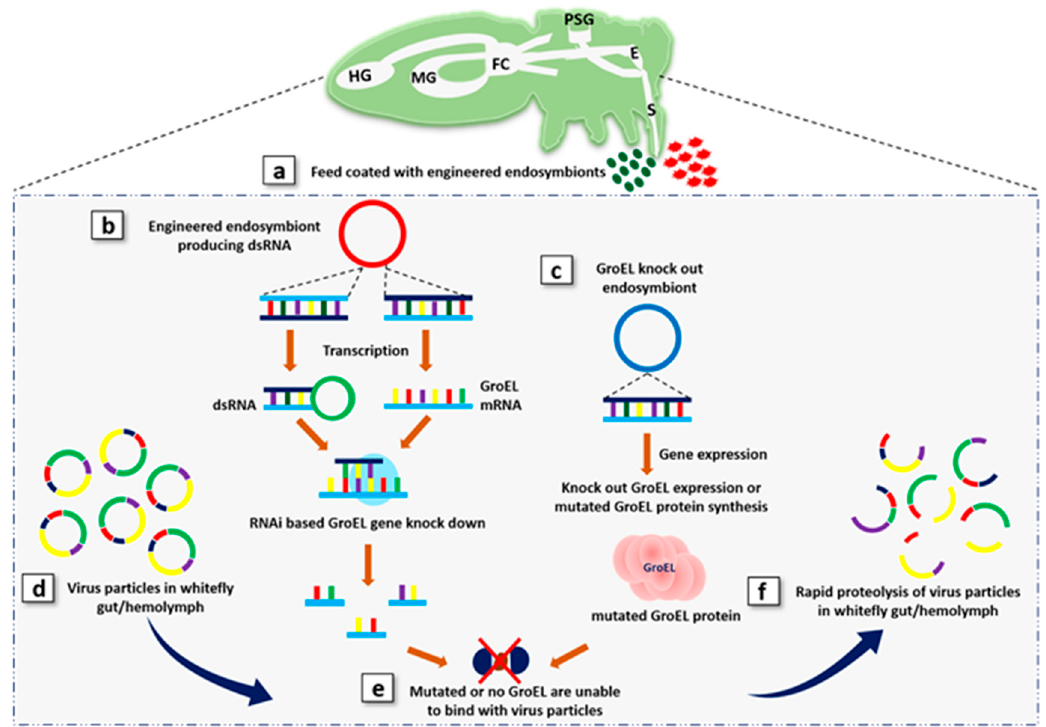
Figure 3. A proposed strategy to knockdown virus transmission by whitefly with the CRISPRCas9 system and RNA interference (RNAi) approach. ( a ) Feed coated with dsRNA, producing engineered bacterial endosymbionts (green particles) and the knockout/mutated GroEL gene, containing engineered bacterial endosymbiont (blue particles). ( b ) Whitefly ingesting engineered bacterial endosymbionts expressing dsRNA to evoke the RNAi mechanism to knockdown the GroEL mRNA produced by endosymbiotic bacteria. ( c ) Whitefly-feasting engineered bacterial endosymbionts with GroEL knockout or mutant protein expression. ( d ) Virus particles in whitefly gut/hemolymph from infected plants. ( e ) Mutated GroEL protein, which is unable to protect virus particles. ( f ) Virus particles would be rapidly degraded by proteolysis in the gut/hemolymph by the whitefly immune system.